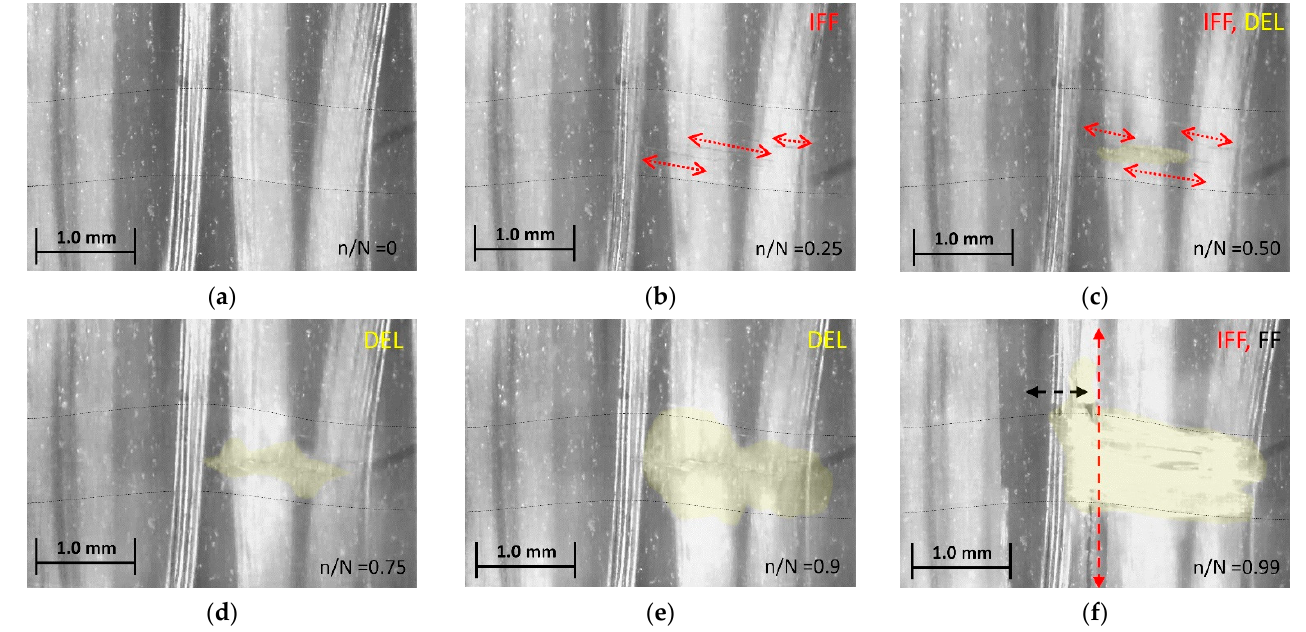
Figure 18. Representative micrograph sequence (reflected light in situ microscopy of the specimen surface), illustrating the occurrence of transverse inter-fiber cracking (IFF), delamination (DEL) and fiber-fracture (FF) in the AlFGFRP material under fatigue loading. The images depict the damage states after 0% ( a ), 25% ( b ), 50% ( c ), 75% ( d ), 90% ( e ) and 99% ( f ) of the cycles to failure.